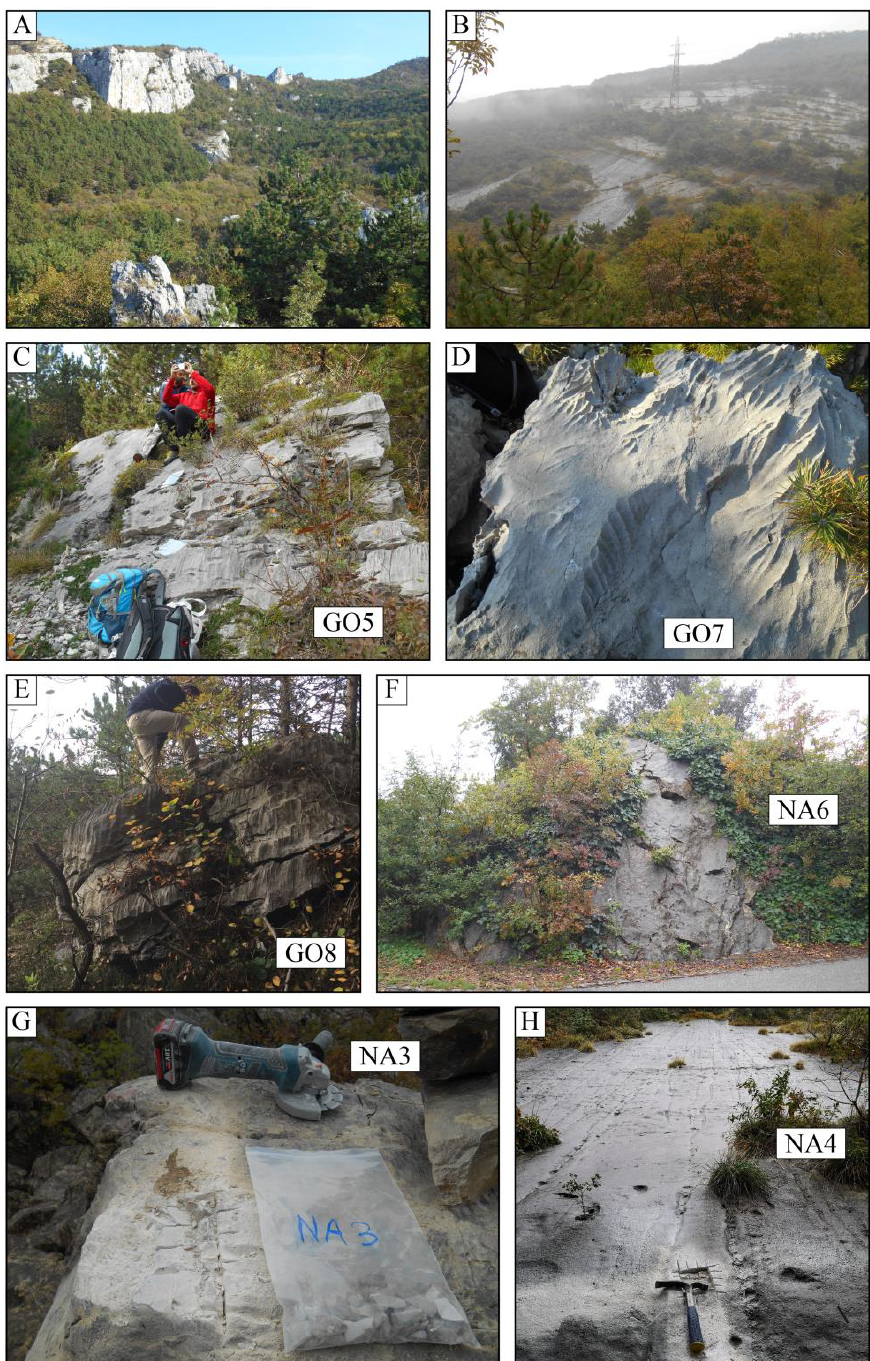
Figure 8. Photos from the study area. ( A ) The northern flank of the Paternoster release area, taken from the Tiro a Volo area. The wall in the upper left is 80 m high. Several rock spires are visible in the background. ( B ) View of the Navesele – Salto della Capra release area. The power line tower is about 30 m tall. The photos in the second and third lines are of samples from the Gorte rock avalanche deposit. ( C ) Boulder GO5 (6.1 ± 0.4 ka). The sample for 36 Cl dating was taken from the top surface. ( D ) Karren on the top sampled surface of boulder GO7 (7.2 ± 0.5 ka). ( E ) Boulder GO8 (5.7 ± 0.4 ka), where the top slightly sloping surface was sampled. ( F ) Boulder NA6 (6.3 ± 0.4 ka) is 6 m high. The bottom two photos are samples of the Navesele rock avalanche. ( G ) Sampled surface of boulder NA3 (2.4 ± 0.2 ka). ( H ) Sampled Navesele bedrock detachment surface of NA4 (5.9 ± 0.4 ka).